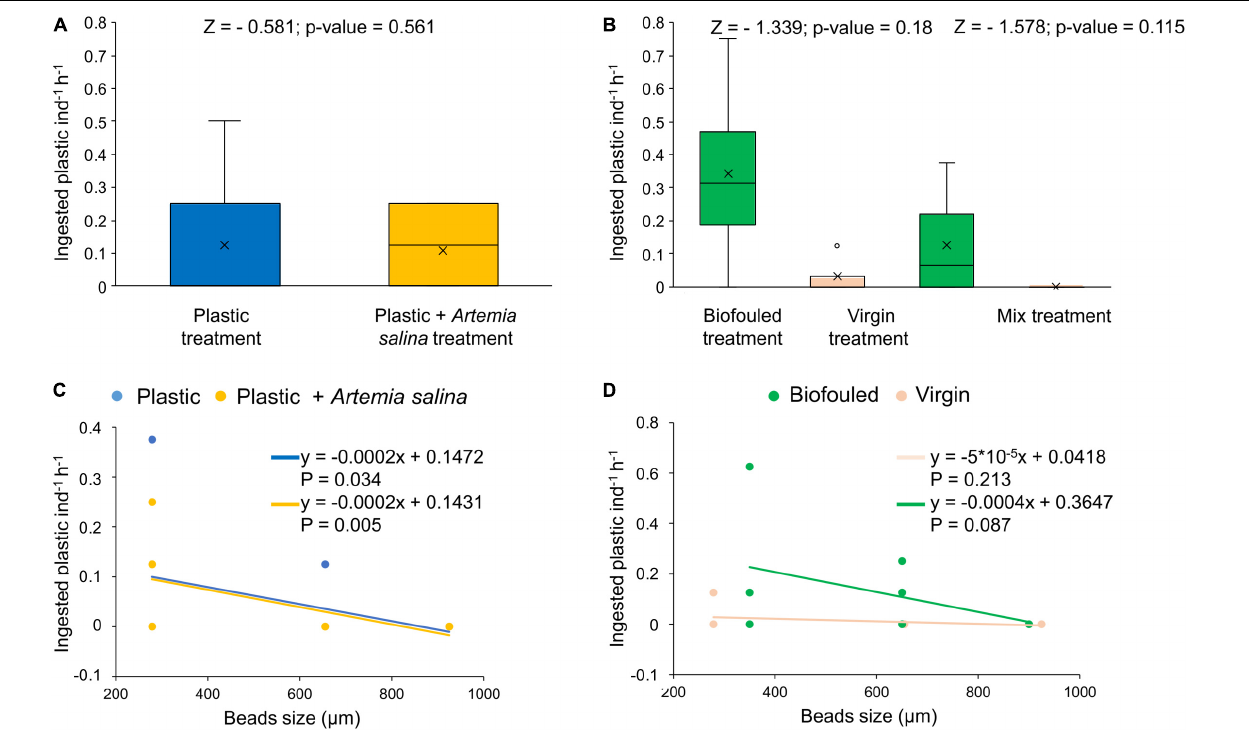
FIGURE 2 | Plastic removal by ingestion and distribution of ingested plastic in size classes (uncorrected values). (A) Ingested plastic (number of microplastic beads individual - 1 hour - 1 ) in corals exposed to two treatments: corals treated with plastic (“Plastic,” in blue, N = 7) and treated with plastic mixed with Artemia salina (“Plastic + A. salina ,” in yellow, N = 7). (B) Ingested plastic (number of microplastics individual - 1 hour - 1 ) in corals exposed to three treatments: corals treated with biofouled plastic only (“Biofouled,” in green, N = 4), with virgin plastic only (“Virgin,” in pink, N = 4) and biofouled plastic (in green), and virgin plastic (in pink) mixed (“Mixed,” N = 6). All estimates have been compared with Wilcoxon tests for which the p -value and Z value are reported in the figures. (C) Distribution of ingested plastic in size classes in the Plastic treatment (blue) and in the Plastic + A. salina treatment (yellow). (D) Distribution of ingested plastic in size classes in the Virgin treatment (pink) and in the Biofouled treatment (green). In plots (C,D) , size classes are reported as the mean value of the size class bin. Lines represent the linear fit of each set of data of the corresponding color. Equations and p -values of each linear model are reported in